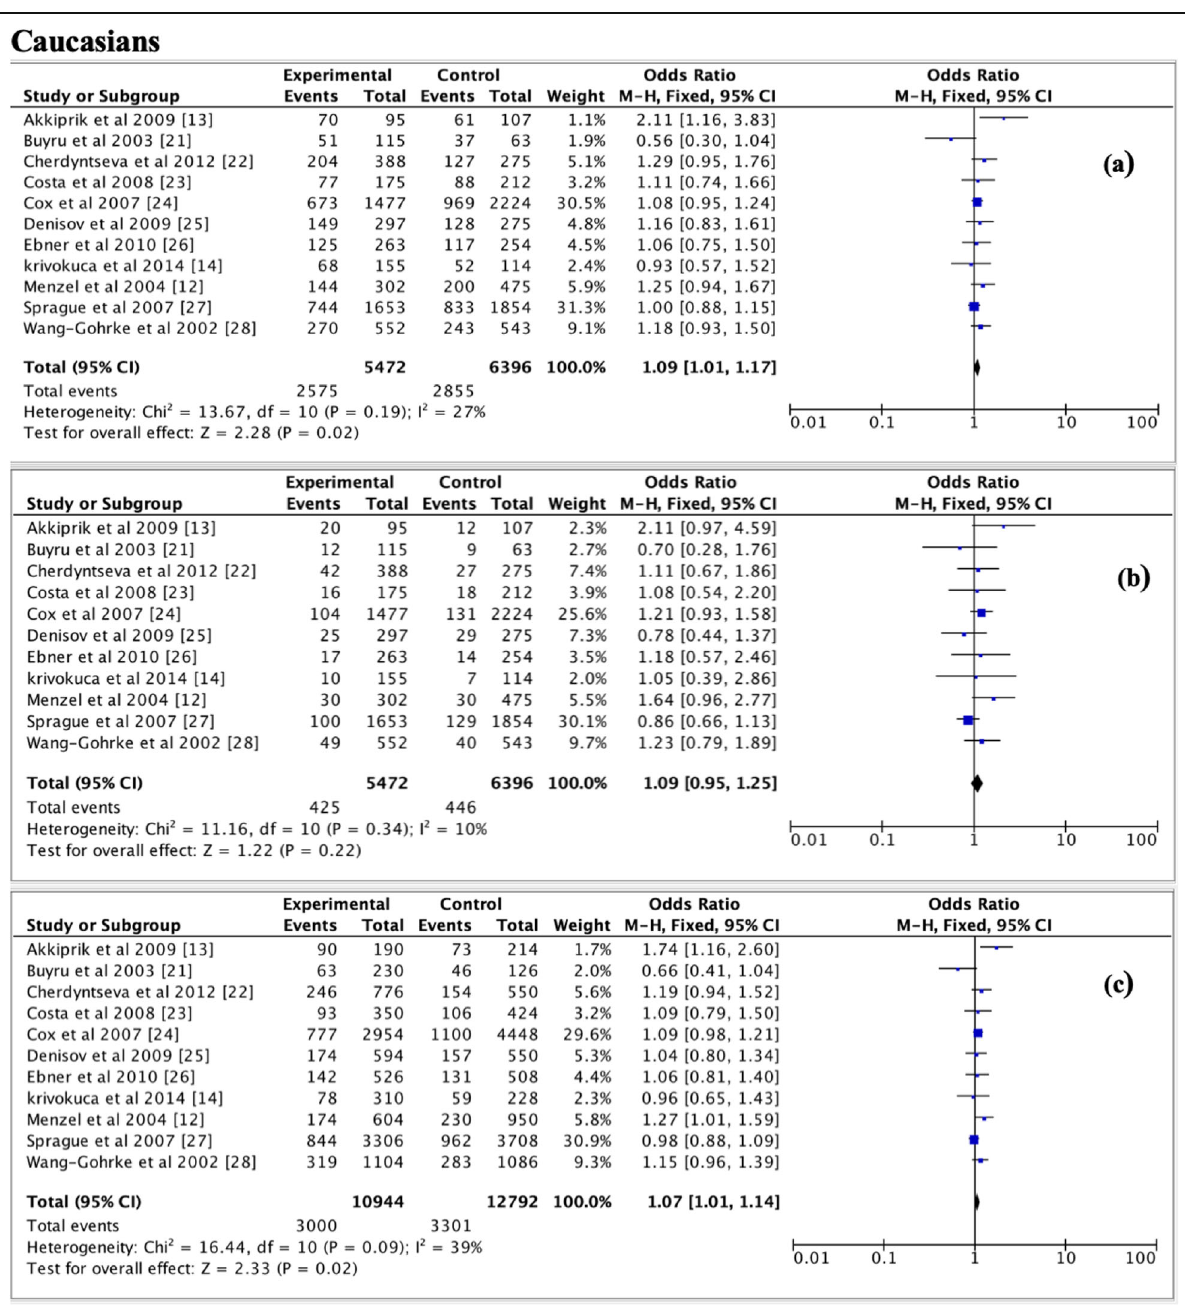
Fig. 5 Forest plots of the association between breast cancer and TP53 p.Arg72Pro polymorphism for the a dominant model, b recessive model and c additive model in Caucasians. The black diamond denotes the pooled OR; blue squares indicate the OR in each study with square sizes inversely proportional to the standard error of the OR; and horizontal lines represent the 95%